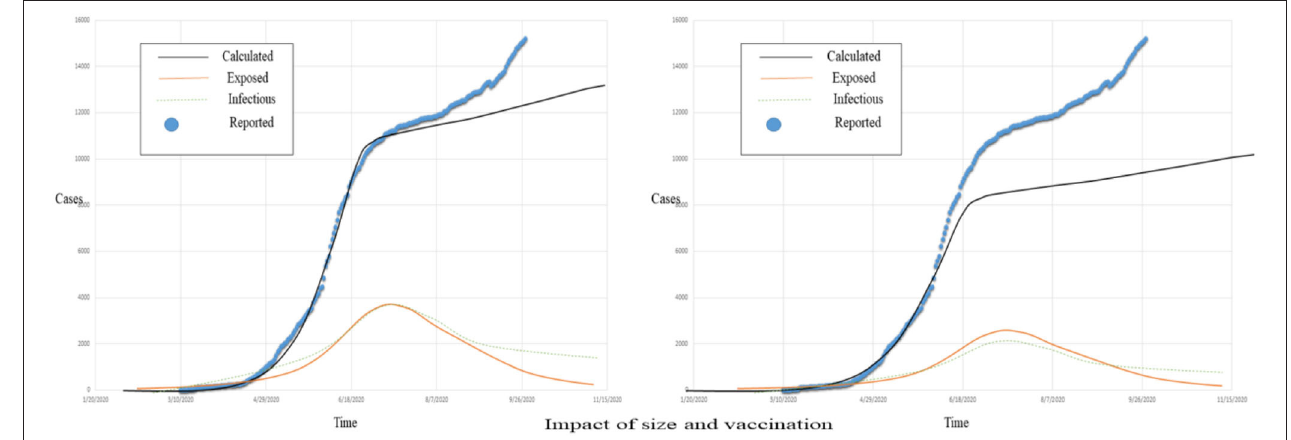
FIGURE 12 | The population size impact on COVID-19 pandemic spread